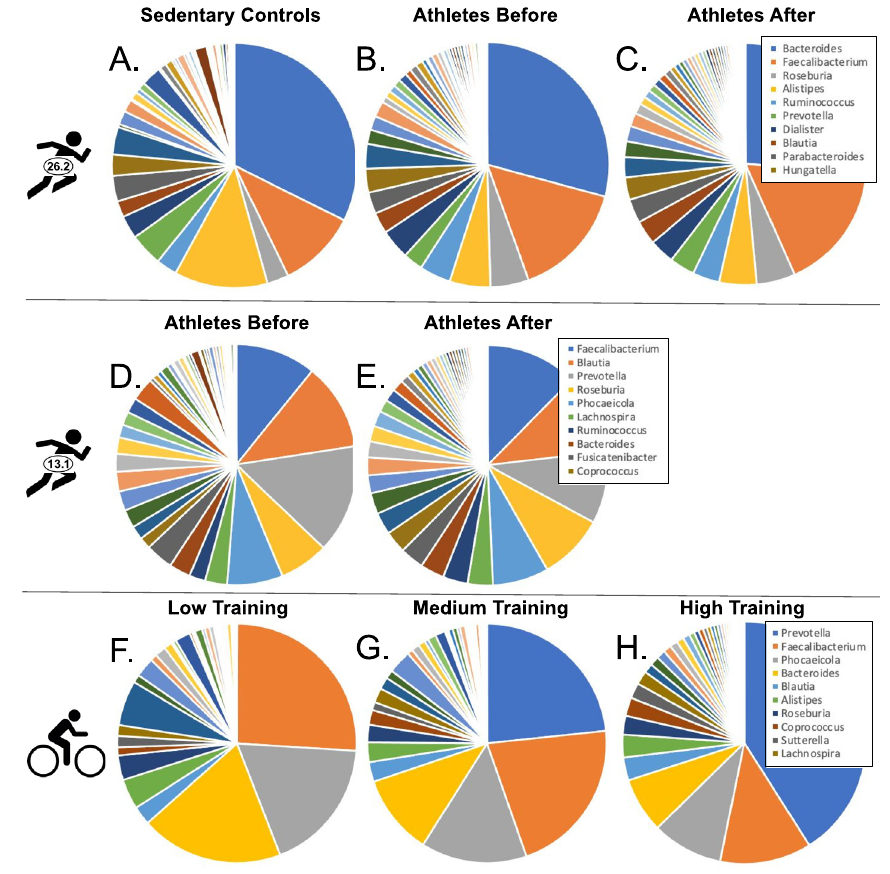
Figure 1. Average proportions of bacterial genera in the eight comparison groups. Data are from Boston Marathoners ( A – C ); Chongqing Half-Marathoners ( D , E ); competitive cyclists ( F – H ). The top 10 most abundant genera for the highest performing treatment group are indicated in the legend for each dataset.